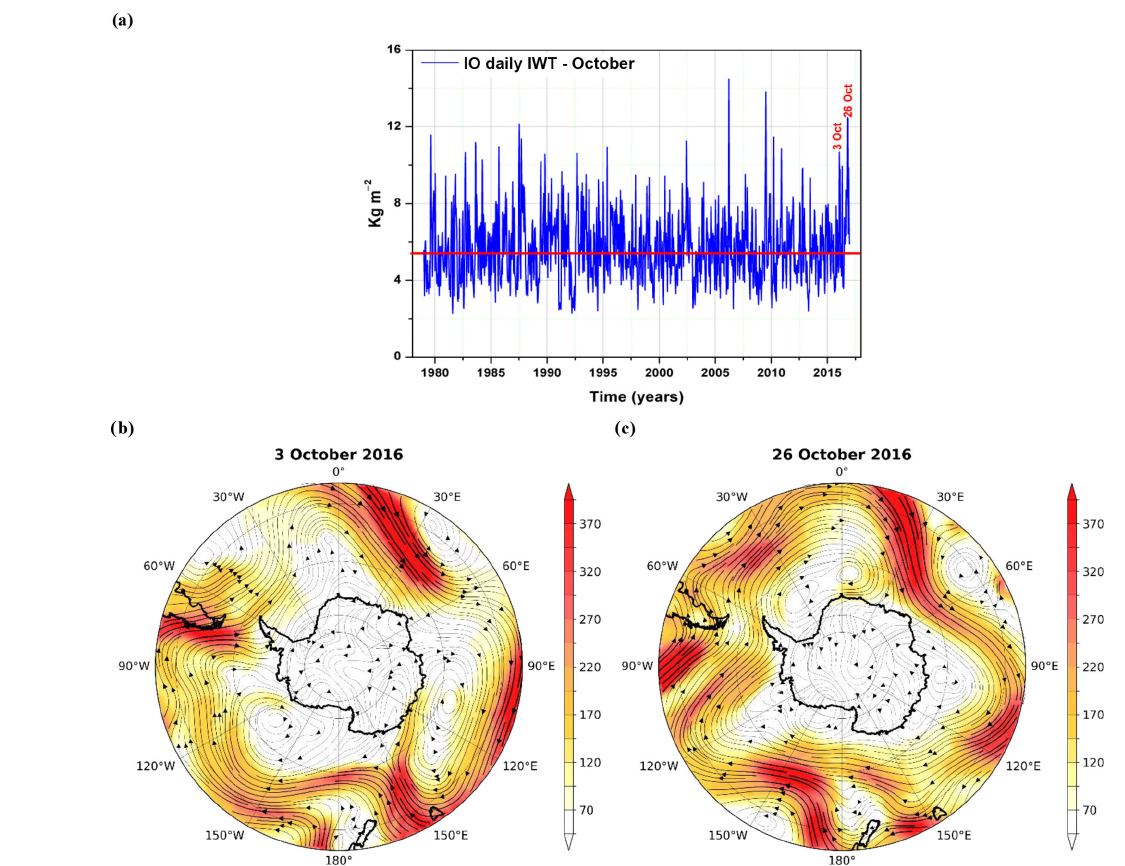
Figure 9. (a) Daily IWT averaged over the IO (black square in Fig. 4e) over the period 1979–2016; (b) the vertically integrated water vapor transport (WVT) on 3 October 2016 and (c) as in (b) but for 26 October 2016. In (b) and (c) the color-shaded areas indicated the magnitude of the moisture transport and the vectors the direction of the moisture